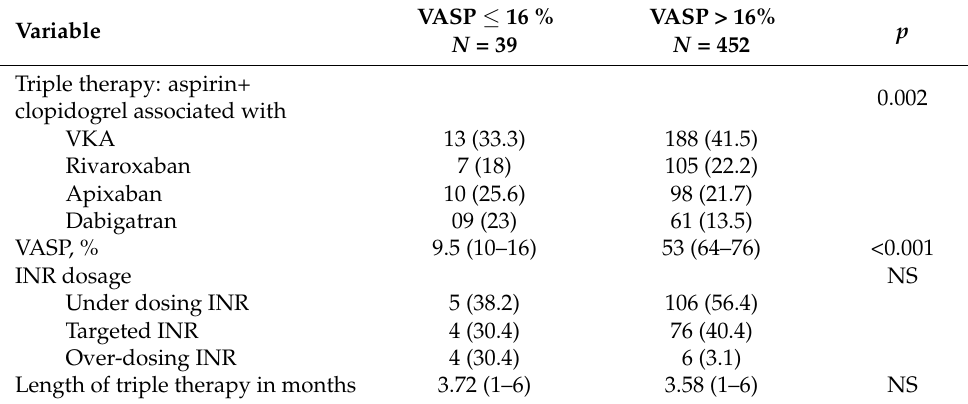
Table 6. Indication for anticoagulation, major adverse cardiac or cerebrovascular events and bleedings for patients with six months follow-up, VASP cut-off 16% ( N =